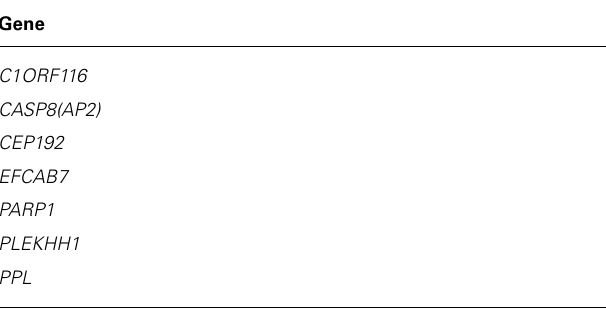
Table 2 | Overlap between the list of differentially expressed genes in vocal learners inWang (2011) and the list of genes found to